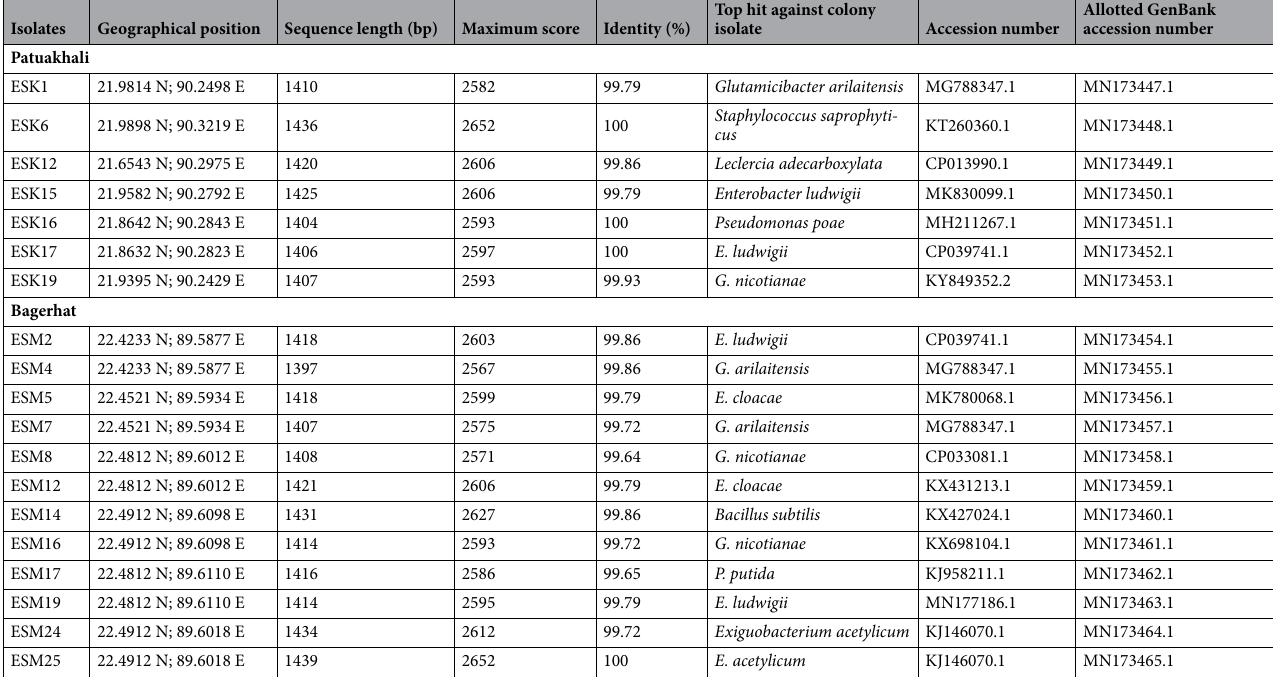
Table 1. Identification of halotolerant biofilm producing rhizobacteria isolated from coastal regions of Bangladesh.